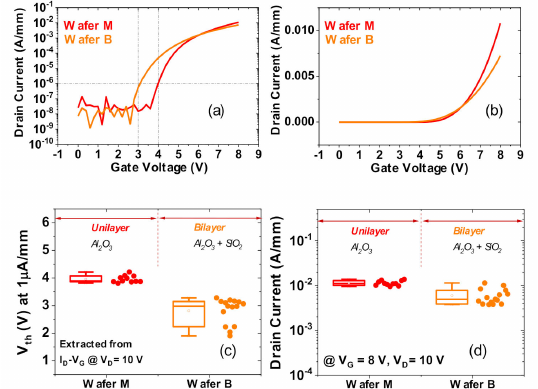
Figure 5. Comparison of transfer characteristics between Wafer M (uni-layer oxide) and Wafer B (bilayer oxide). Typical I D -V GS results at V DS = 10 V in ( a ) log scale and ( b ) linear scale. ( c , d ) box charts with statistics of threshold voltage (V th ) ( c ) and I DS current levels at V GS = 8 V and V DS = 10 V ( d ).